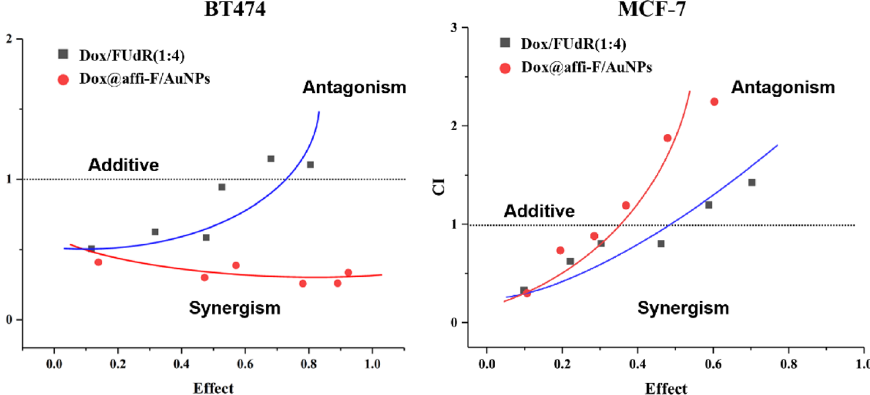
Figure 8. Synergetic effect analysis of Dox/FUdR (1:4) and Dox@affi-F/AuNPs in BT474 and MCF-7 cells. The combination index (CI) value was calculated by Compusyn software (http://www.combo syn.com). The CI values greater than 1, equal to 1 and less than 1 are considered as antagonistic, additive and synergistic effects,